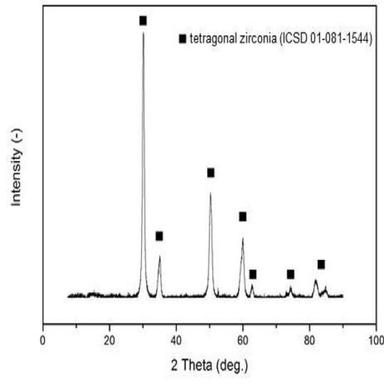
SEM micrographs (SE-mode) of the 3Y–Zr fibers sintered with a heating rate of 1 K/min a) 1100 °C and b) 1350 °C.